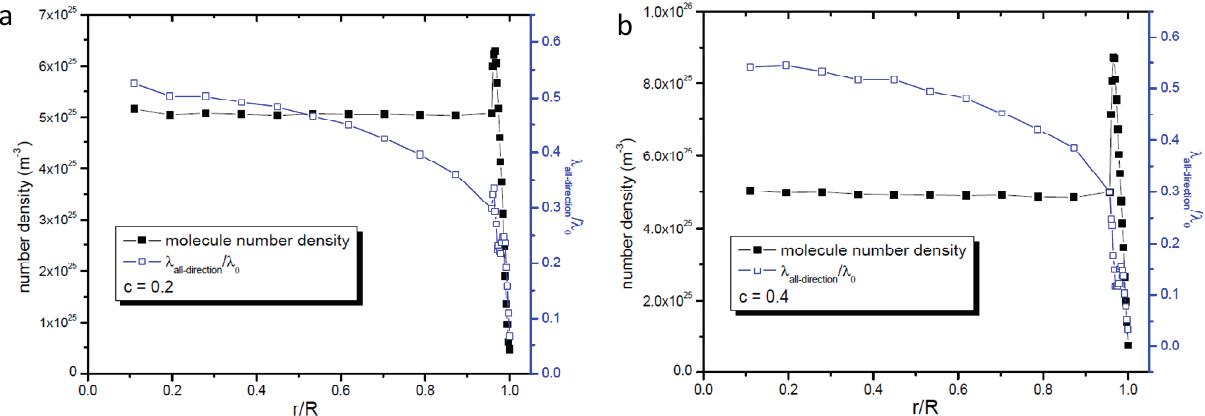
Figure 5 . Profiles of gas molecular mean free path and gas number density. ( a ) c = 0.2; ( b ) c = 0.4; and ( c ) c =